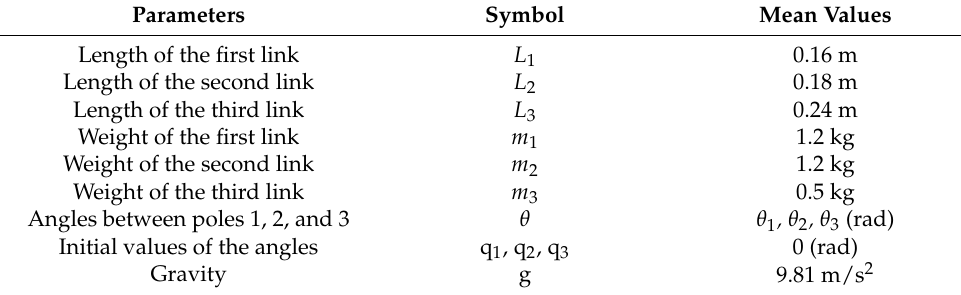
Table 1. Robogymnast parameters